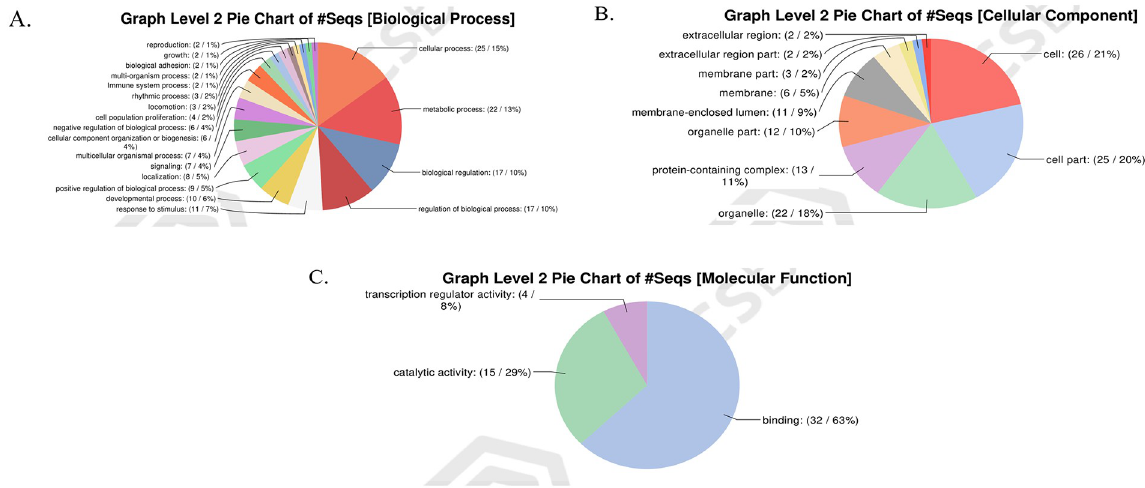
Fig 4. Functional classification of genes in reverse library. (A) Classification of biological processes level. (B) Classification of cell component level. (C) Classification of molecular function level.